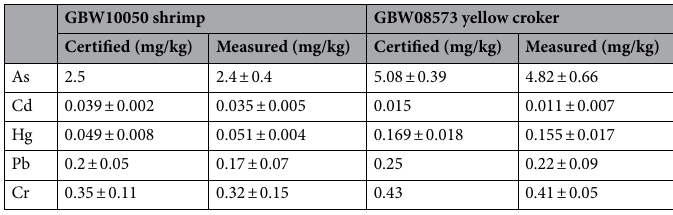
Table 1. Determination of certified reference materials.